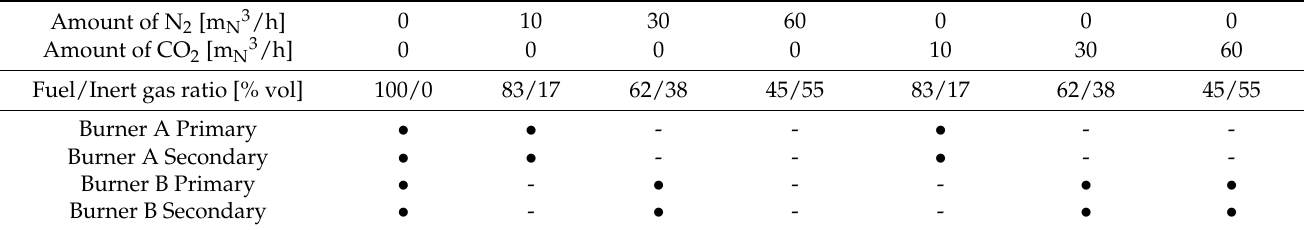
Table 8. Experimental matrix—TEST B, C—Burners A, B ( ● indicates that the test was carried out).